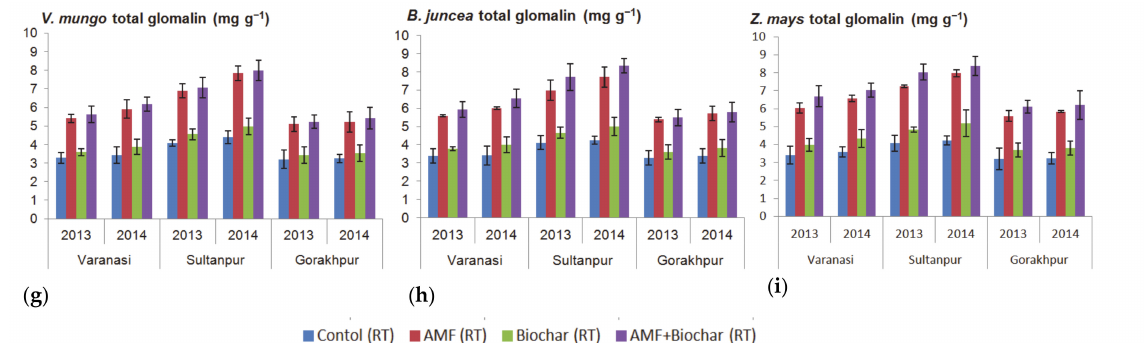
Figure 3. Soil enzymes, i.e., urease, β -glucosidase, and glomalin, activity results showing significant improvement under sustainably integrated SAI-managed fields in comparison to the control at three experimental sites (ES1-Varanasi (V), ES2-Sultanpur (S), and ES3-Gorakhpur (G)) for three crop fields, i.e., urease ( a – c ), β -glucosidase ( d – f ), and glomalin ( g – i ) for V. mungo , B. juncea , and Z. mays , respectively. Data values represent mean ± SD of different treatments ( n = 18) with significant difference ( p =